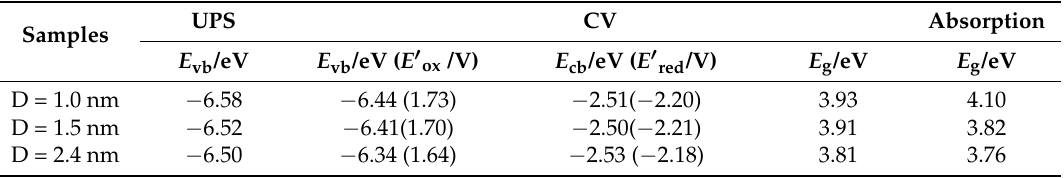
Figure 7. Cyclic voltammograms ( a ) and UPS spectra ( b ) of the as-prepared ZnS USNWs of different diameters. The inset in ( b ) is the magnified view of the low energy edge of the spectra. Table 1. E vb , E cb , and E g values of the as-prepared ZnS nanowires (NWs) of different diameters measured by CV and